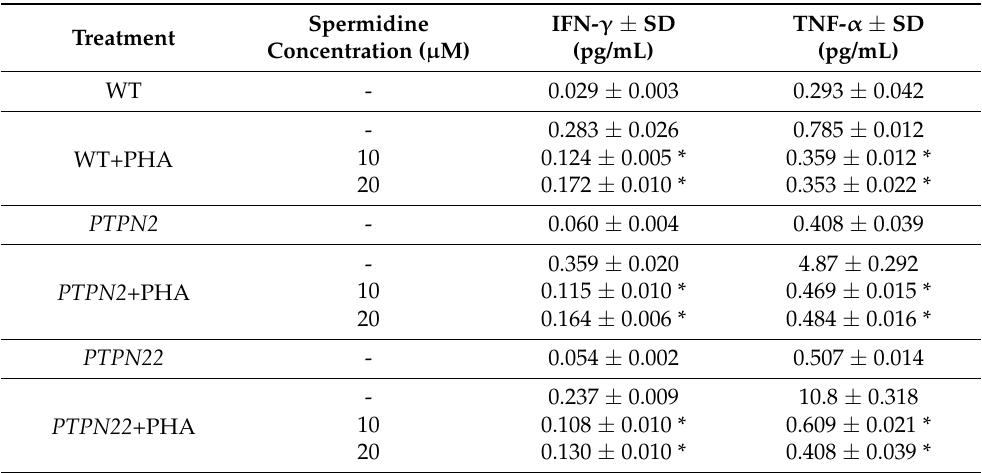
Table 5. Effect of Spermidine on IFN- γ and TNF- α Secretion in CRISPR-Cas9-edited Jurkat T-cells Stimulated with